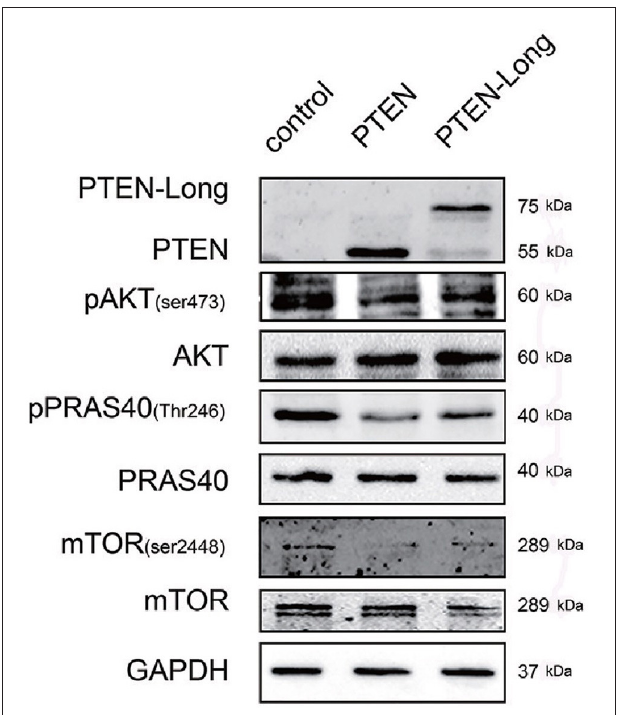
FIGURE 5 | PTEN-Long inhibits PI3K-AKT signaling. Western blot analysis of PI3K-AKT signaling-related proteins in HepG2 cells ectopic-expressing PTEN or PTEN-Long.